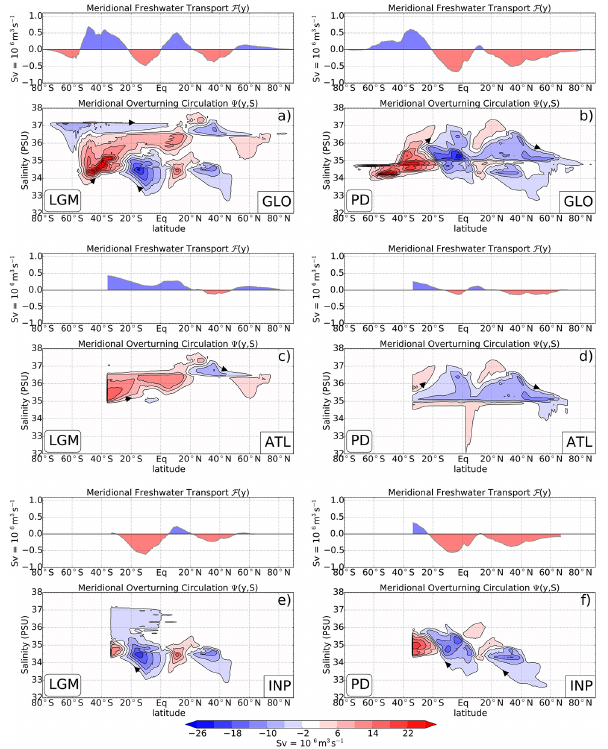
Figure 5. LGM and PD meridional overturning circulation in lati- tude–salinity coordinates for (a, b) the Global Ocean, (c, d) the At- lantic basin, and (e, f) the Indo-Pacific basin. The contour interval for the circulation is 4Sv. The blue cells correspond to clockwise circulations whereas the red cells are for counter-clockwise mo- tions. For each basin, the oceanic meridional freshwater transport in Sv is